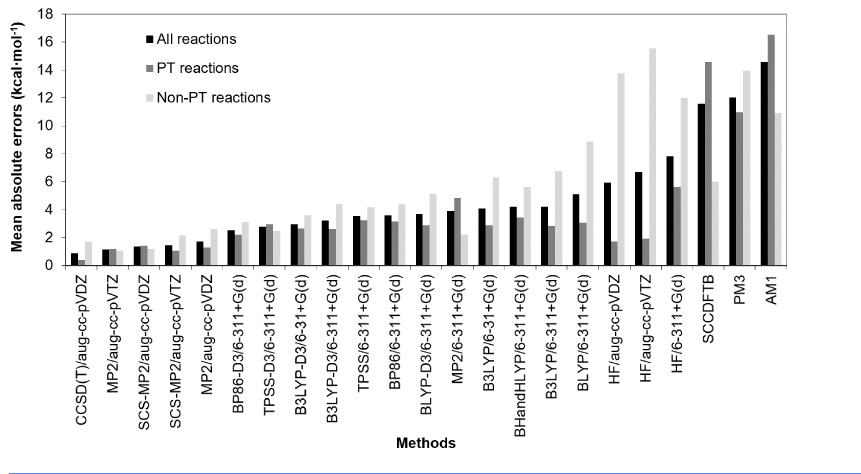
Figure 2 Comparison of mean absolute errors (MAEs) of reaction energies of reaction 1–20, MAEs of proton transfer reactions (PT reactions) and MAEs of non-proton transfer reactions (non-PT reac- tions). The mean absolute errors were given relative to the CCSD(T)/aug-cc-pVTZ (in kcal mol − 1 ). Full-size DOI: